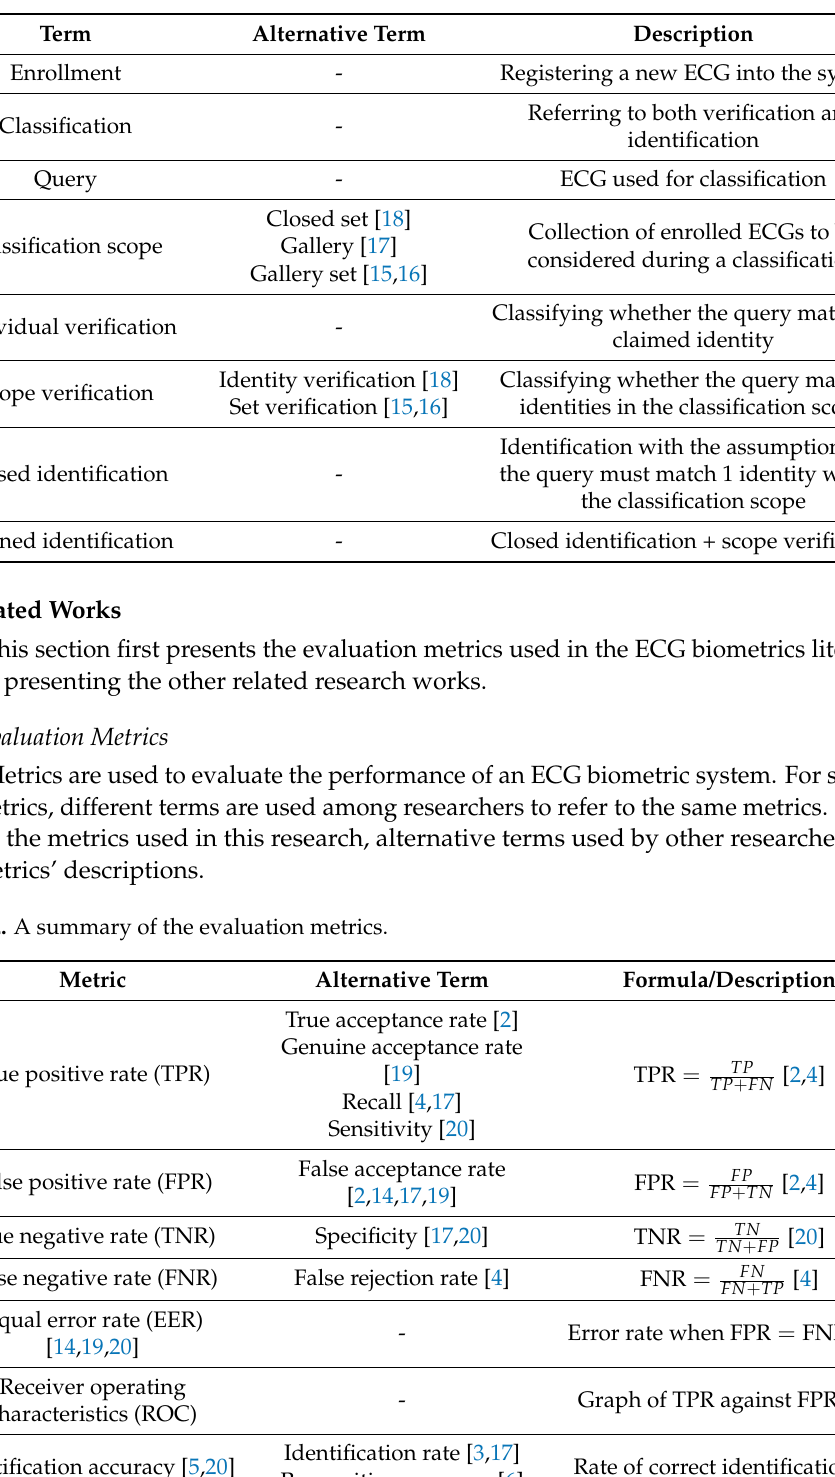
Table 1. A summary of the related terminologies.